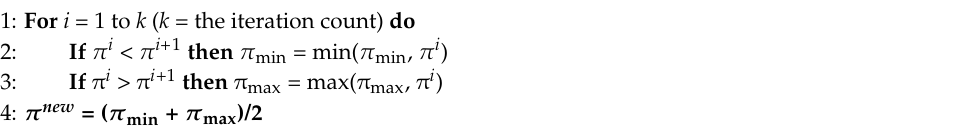
Algorithm 3. Second Stage—Part 1: Update New Price and Equilibrium Limits